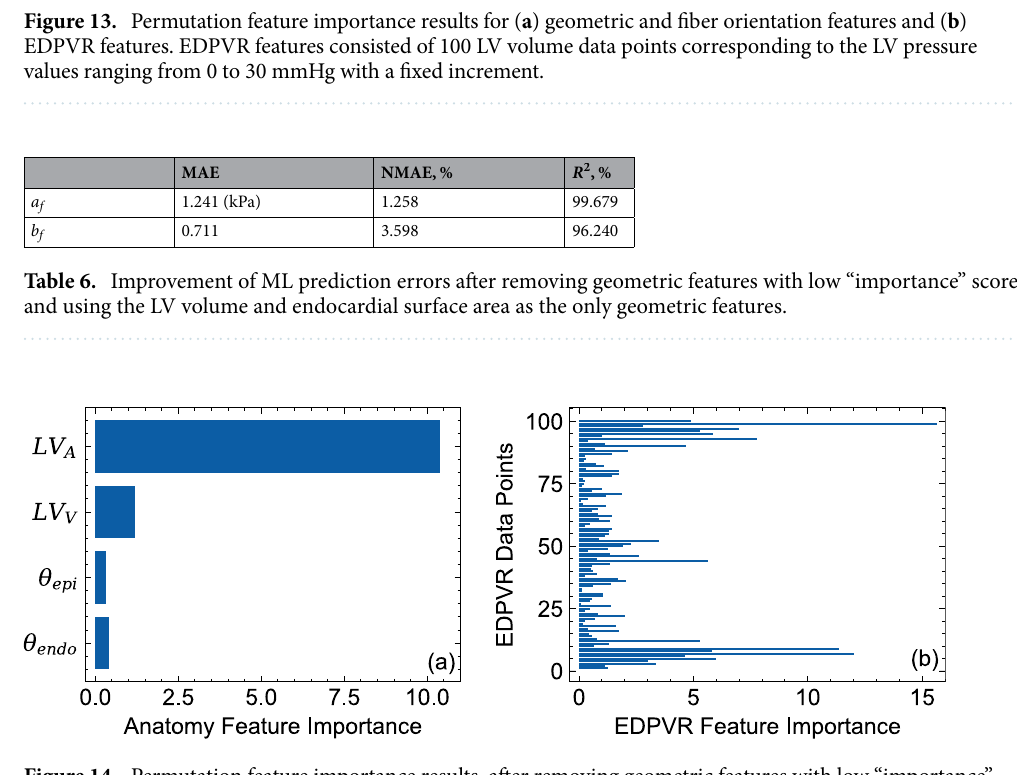
Figure 14. Permutation feature importance results, after removing geometric features with low “importance” score, for ( a ) remaining geometric and fiber orientation features and ( b ) EDPVR features. EDPVR features consisted of 100 LV volume data points corresponding to the LV pressure values ranging from 0 to 30 mmHg with a fixed